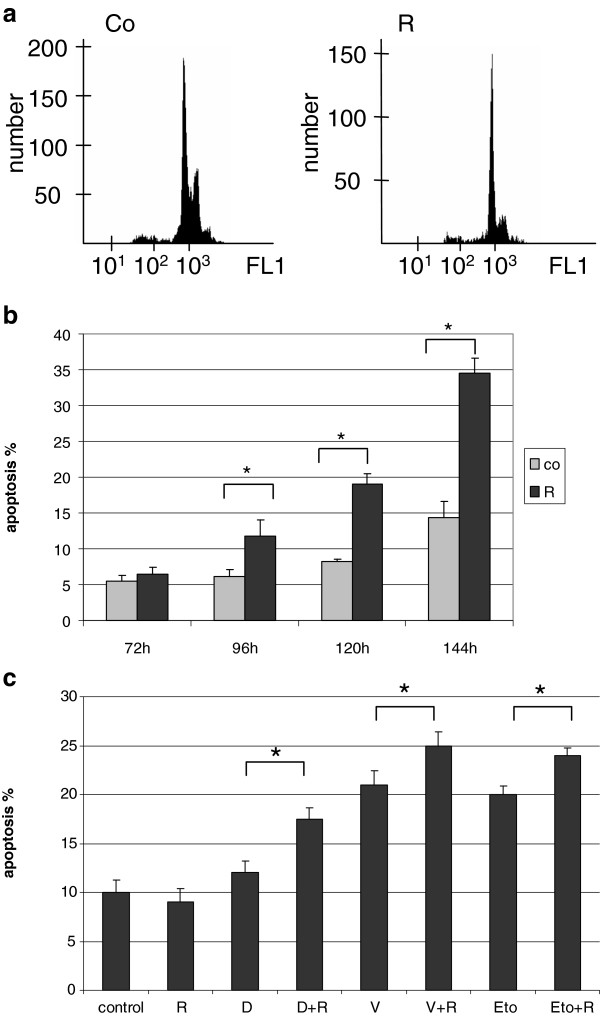
Anti-proliferative and apoptotic effects of rapamycin in vitro. a. G1 cell cycle arrest detected by flow cytometry after 72 h rapamycin treatment (50 ng/ml) in KMH2 Hodgkin-lymphoma cells. b. The apoptotic effect of rapamycin is time dependent in KMH2 cells (flow cytometry, *:p<0.05). c. Rapamycin treatment increased the apoptotic effect of chemotherapeutic agents in HL cell lines after 24 h. A representative experiment in KMH2 cells is shown here. (R: rapamycin 50 ng/ml, D: doxorubicin 0.2 μM, V: vincristine 10 nM, Eto: etoposide 1 μM; *:p<0.05).